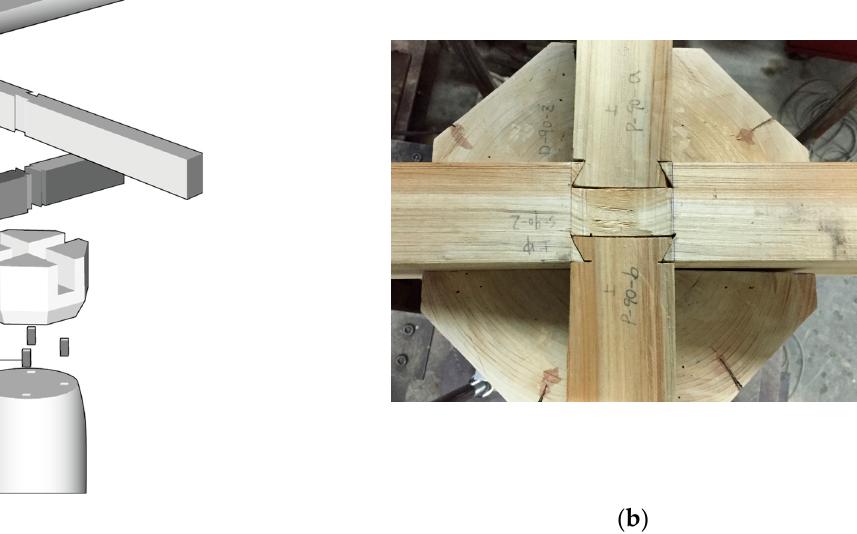
Figure 3. Zuo-Dou as beam-to-column joint: ( a ) connection in the column’s top; ( b ) components on the Zuo-Dou.